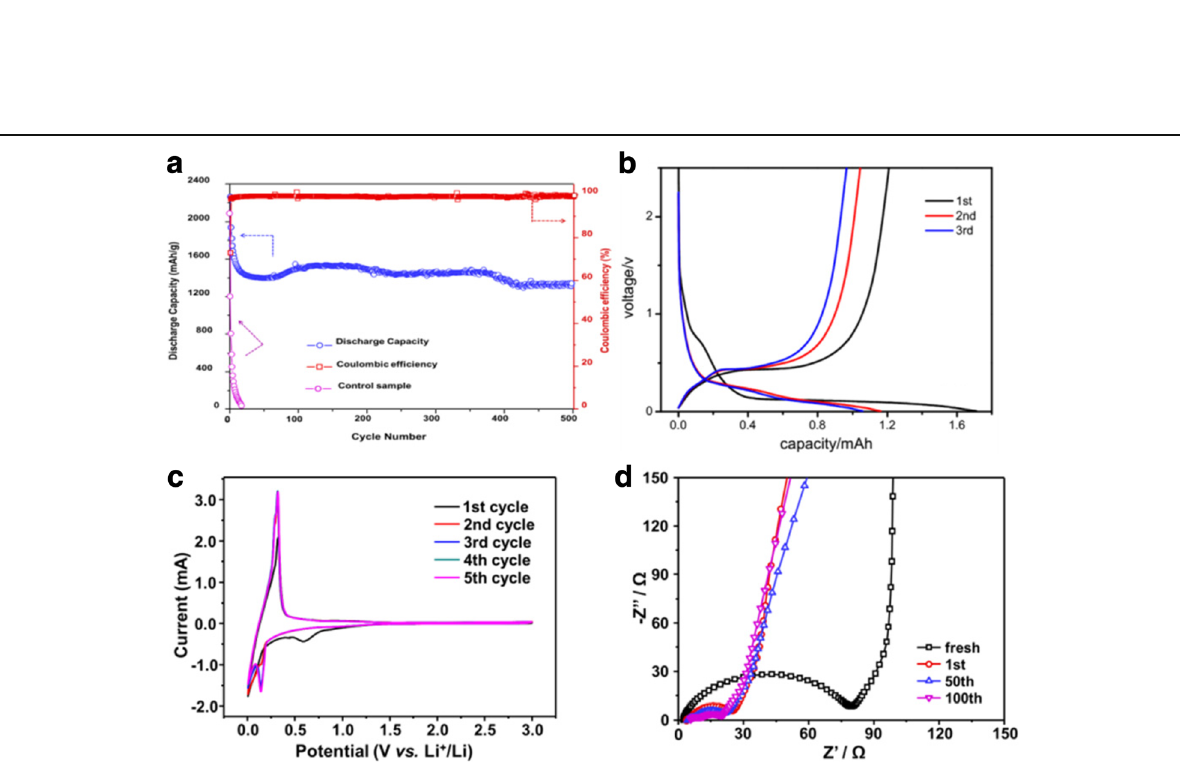
Fig. 4 Electrochemical performance. a Discharge capacity and coulomb efficiency cycling performance of this Si/C composite at rate of 100 mA/ g and comparison with control sample. b Voltage profile of this Si/C composite at 1st, 10th, and 100th cycles. c CV curves of the first 5 cycles of this Si/C composite electrode. d Nyquist plots of the Si/C composite electrodes after several tens cycles at the discharged